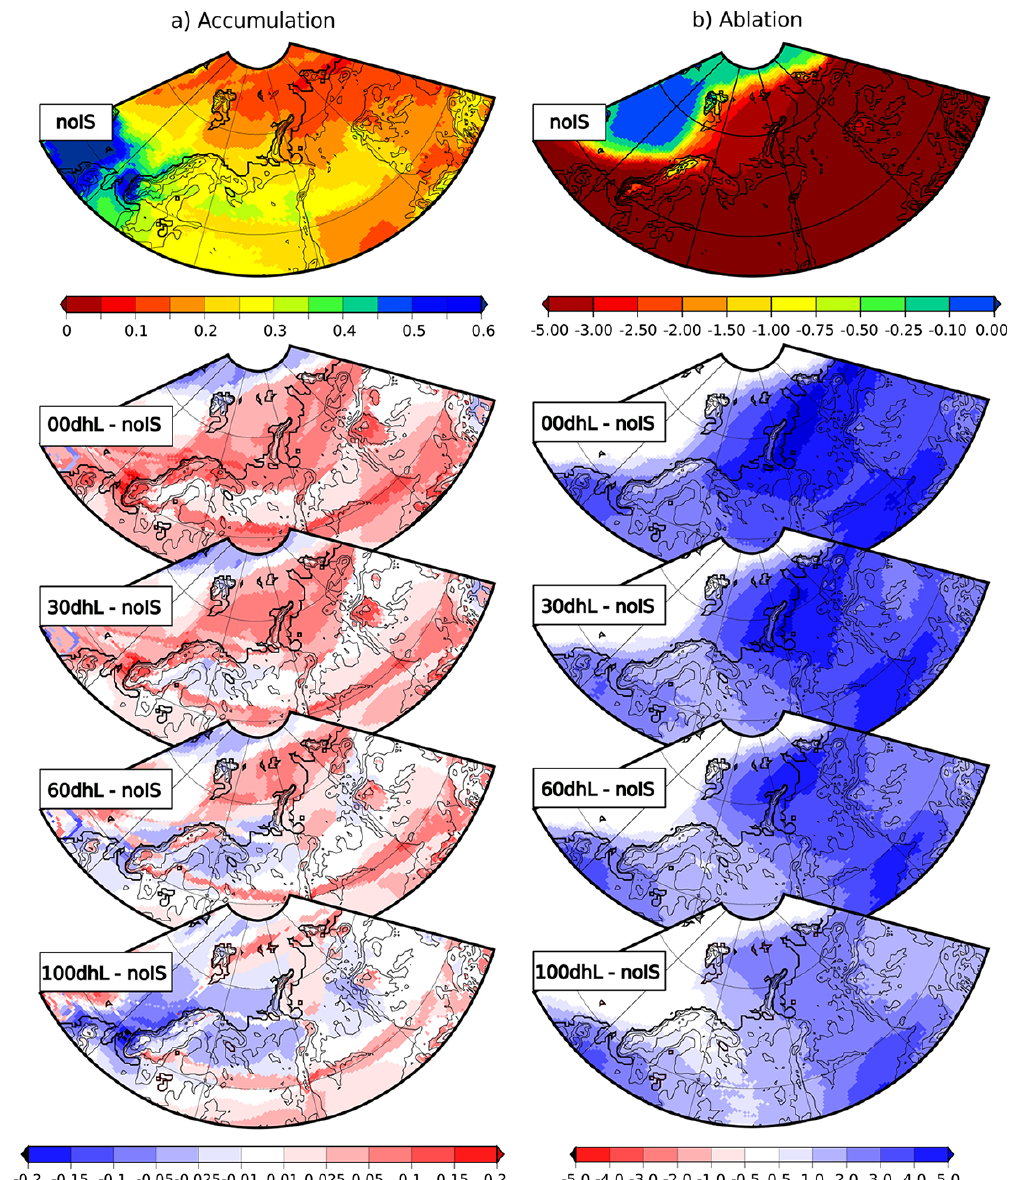
Figure 12. (a) Snow accumulation computed by the GRISLI ice-sheet model for the noIS experiment (top panel), and differences of snow accumulation between the xx dhL and the noIS experiments (in myr − 1 ). (b) same as (a) for the ablation (in myr − 1 ).